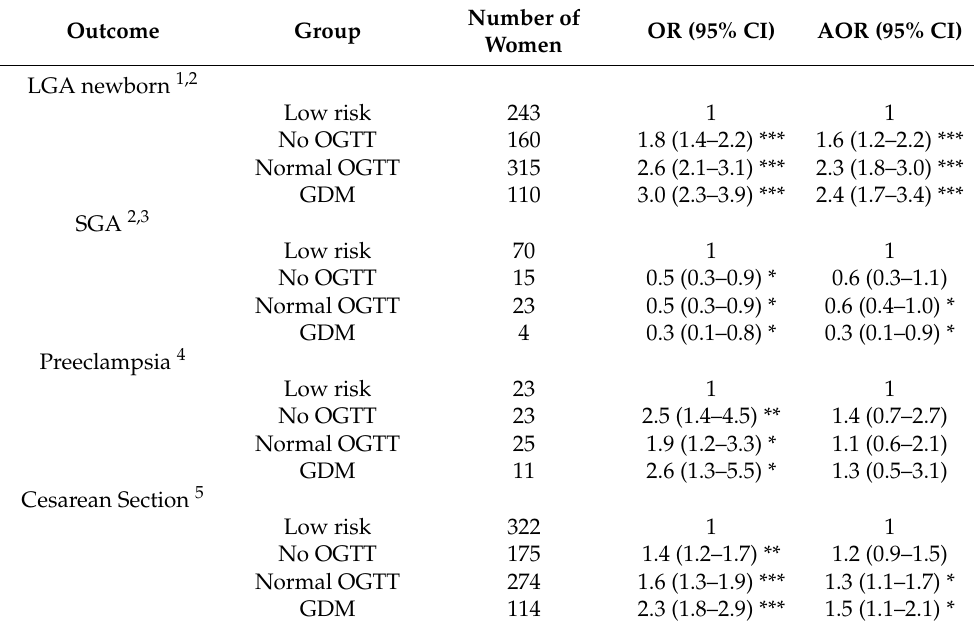
Table 4. Crude and adjusted odds ratios for selected pregnancy outcomes between groups devided according to GDM risk factors and OGTT